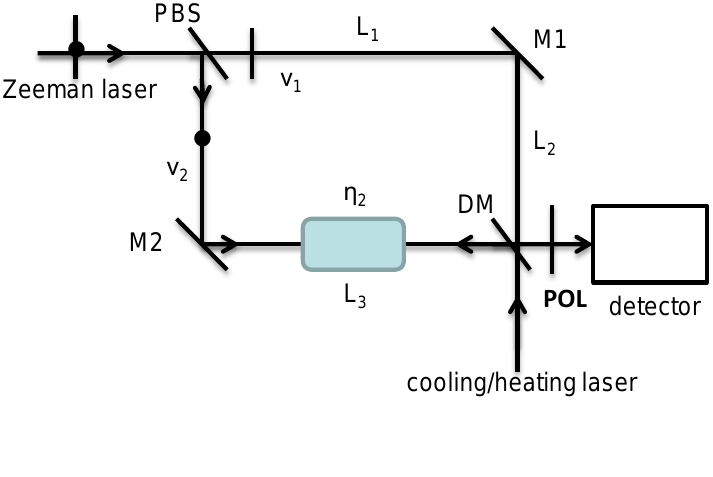
Figure 2. Mach-Zehnder interferometer configuration; p (|) and s (●) -polarization components are spatially separated by a